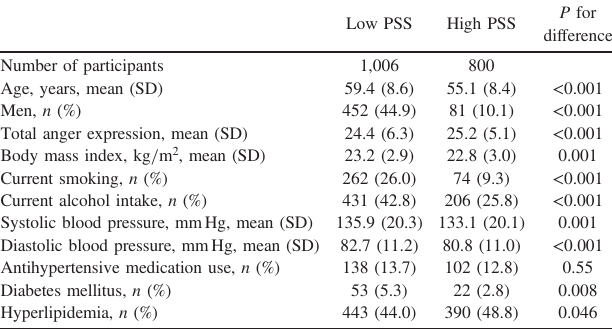
Table 1. Baseline characteristics of participants strati fi ed by perceived social